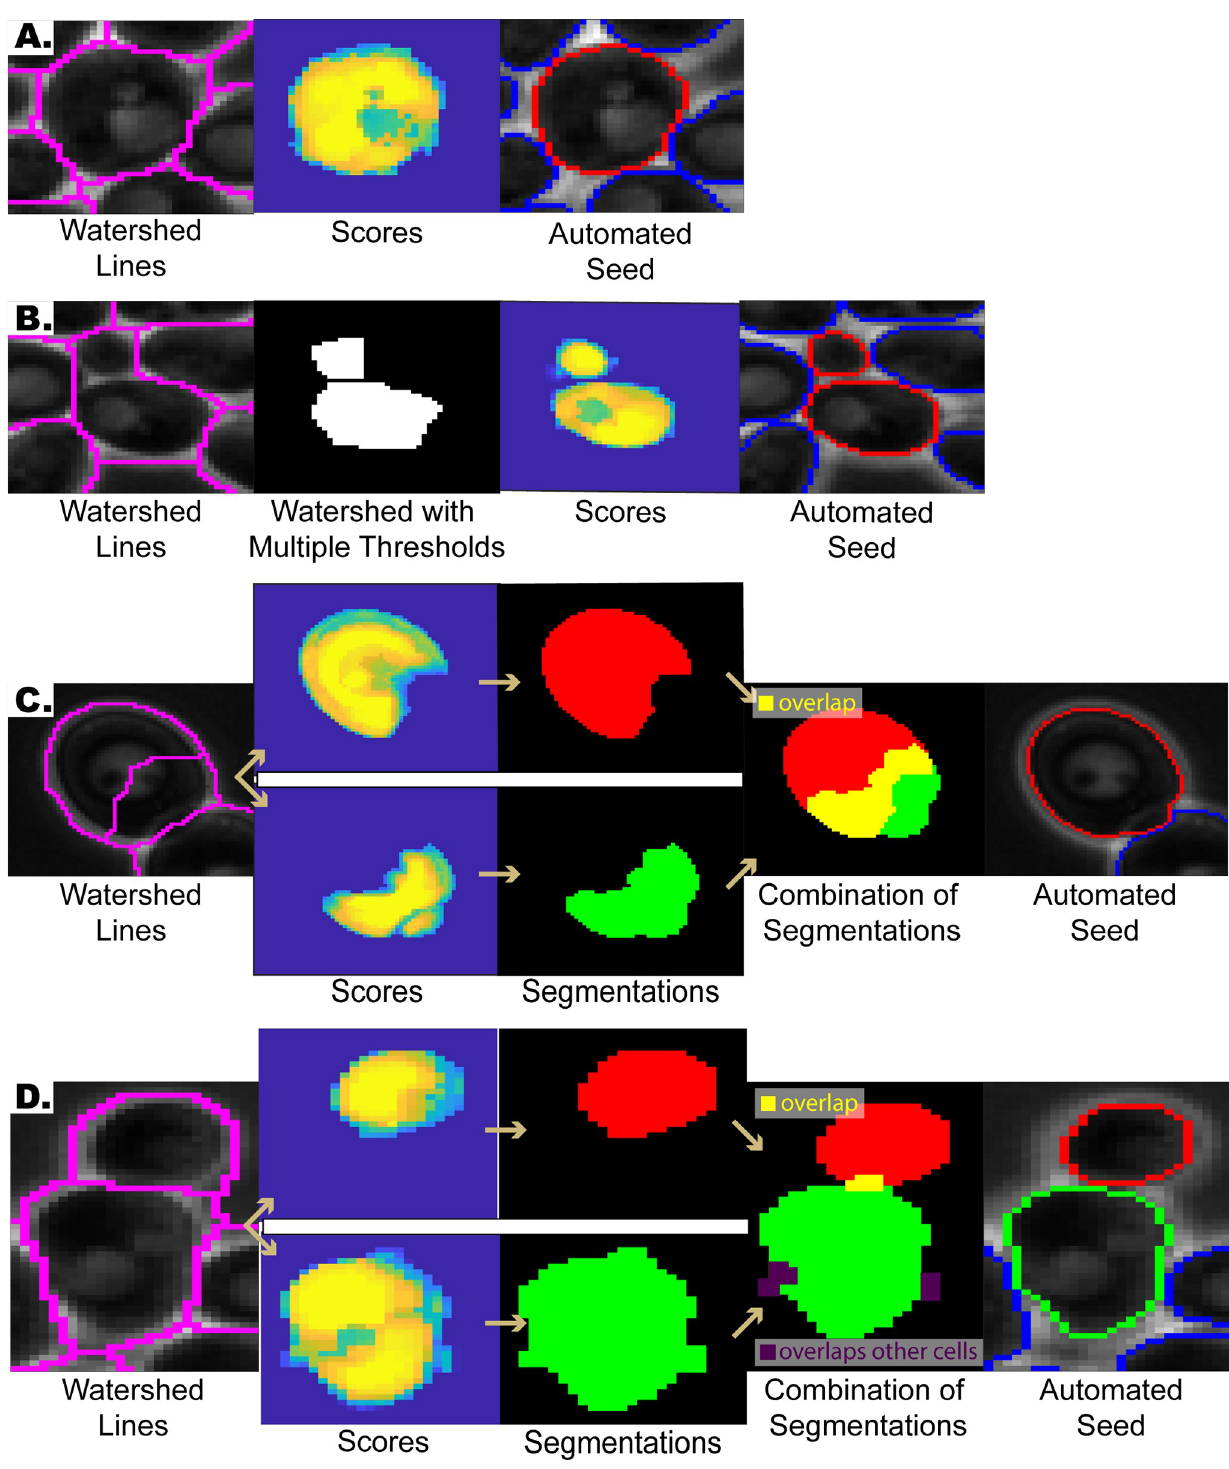
Fig 2. Automated correction & fine-tuning step examples. (A) Refining cell boundaries: The watershed lines do not mark the exact cell boundaries (first column, magenta). Our algorithm automatically fine-tunes these watershed lines and marks the correct cell boundary (third column, red). (B) Under- segmentation correction: Sometimes the watershed lines merge multiple cells (first column, magenta). Such mistakes are detected and corrected automatically (fourth column, red). (C) Over-segmentation correction: Sometimes the watershed lines divide a cell into multiple pieces (first column). After applying the segmentation subroutine several times, each piece converges towards the correct cell segmentation and thus the pieces overlap